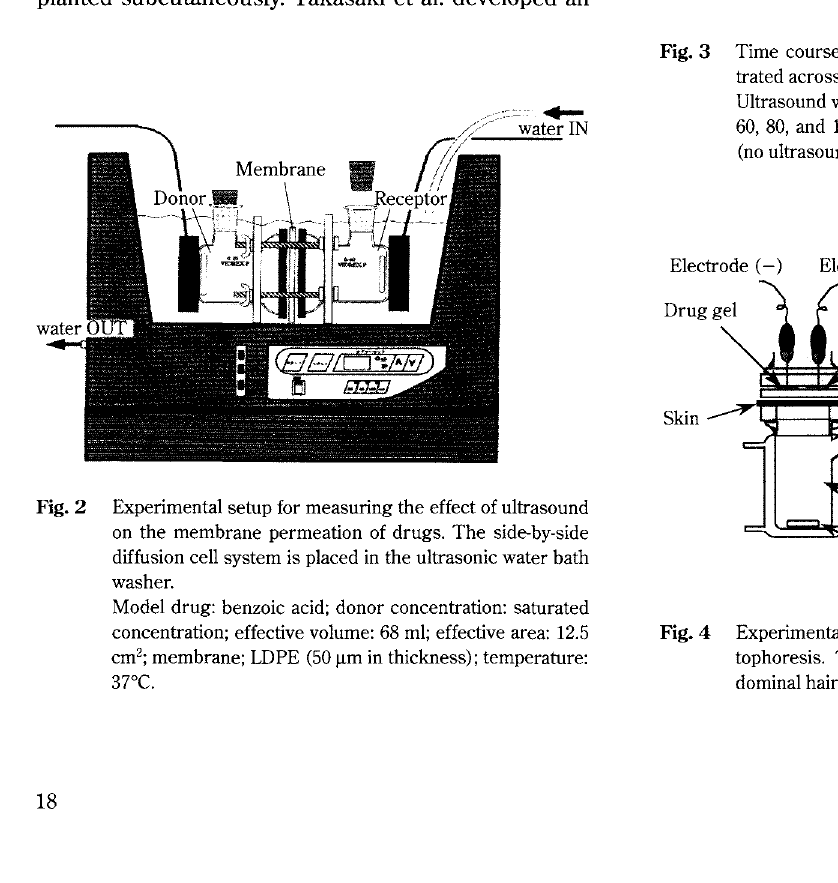
Fig. 3 Time course of cumulative amount of benzoic acid pene trated across an LDPE film. Ultrasound was applied for 10-minute intervals at 0, 20, 40, 60, 80, and 100 minutes (shaded areas). Key: (e) control (no ultrasound), (D) 100kHz, (0) 28kHz, (Li) 45kHz.